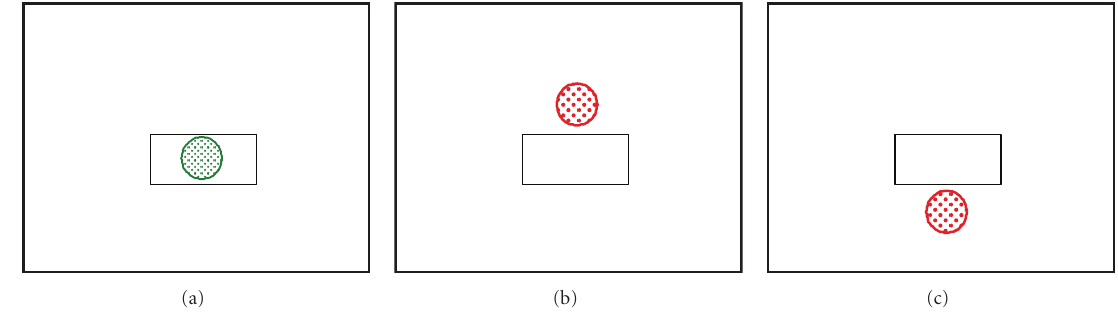
Figure 2: Visual feedback provided during cycling tests and training sessions. Participants are asked to cycle at a target power level or cadence which is represented by the white box on the screen. If the participant is successful, the ball stays within the box and turns green (a). If the participant cycles at a higher (b) or lower (c) power level or cadence, the ball moves out of the box and turns red.